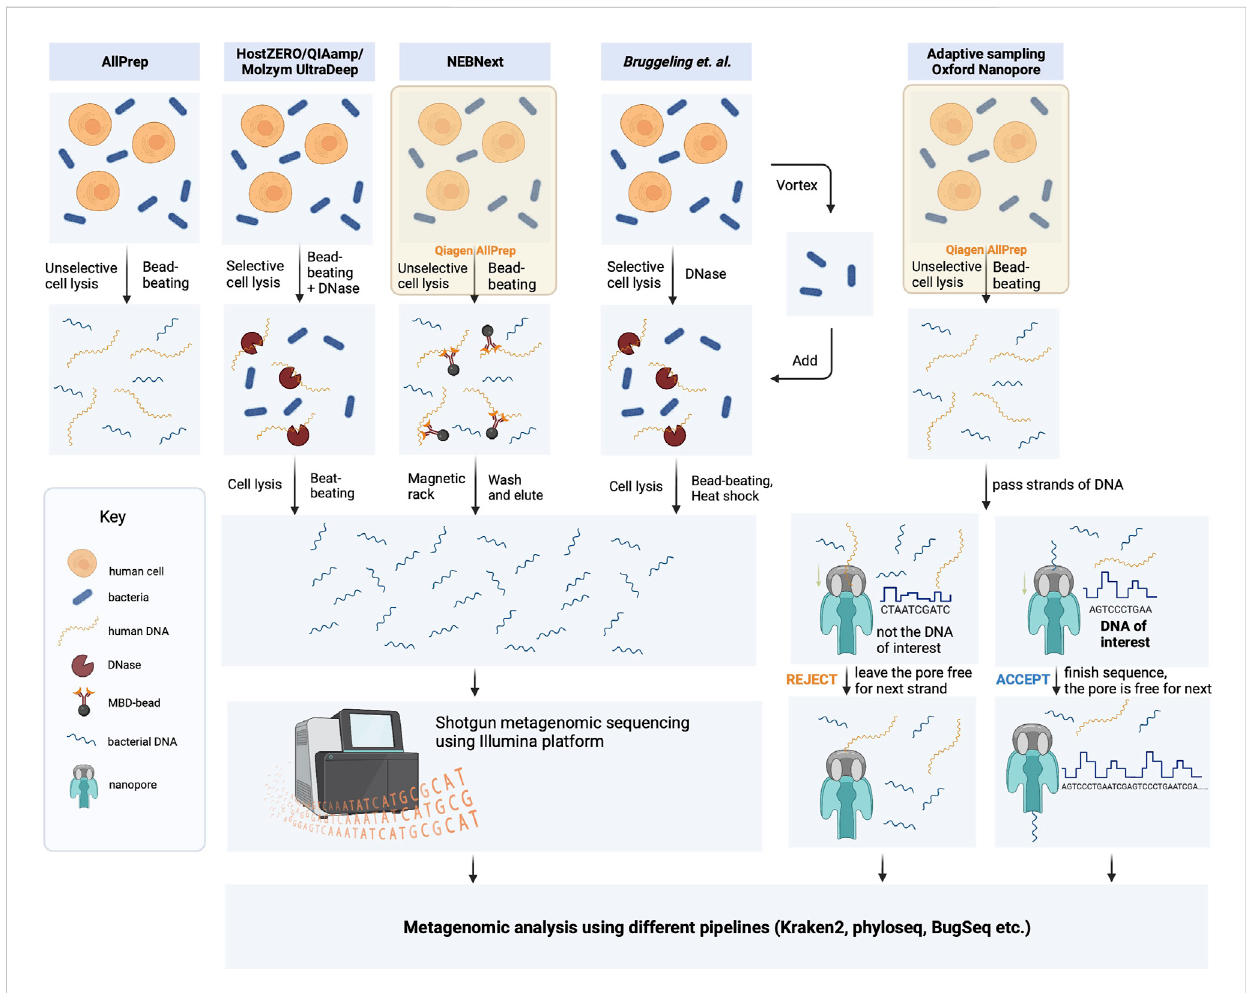
FIGURE 1 Schematic representation of DNA isolation protocol strategies used in this study. The bacterial DNA was extracted from biopsies using fi ve different methods, which included protocols provided by the manufacturers and the laboratory-optimized protocol developed by Bruggeling and colleagues. (Bruggeling etal.,2021).These methods comprised unselective celllysis kits (QiagenAllPrep andNEBNext) andselectivecelllysis kits(HostZero/QIAamp Microbiome and Molyzm UltraDeep), with or without microbiome enrichment. The resulting DNA samples were then sequenced using Illumina NovaSeq 6,000 in 150 bp paired-endmode. Additionally, DNA samples obtained through the Qiagen AllPrep DNA/RNA extractionkit were also analyzed using adaptive sequencing technologies from Oxford